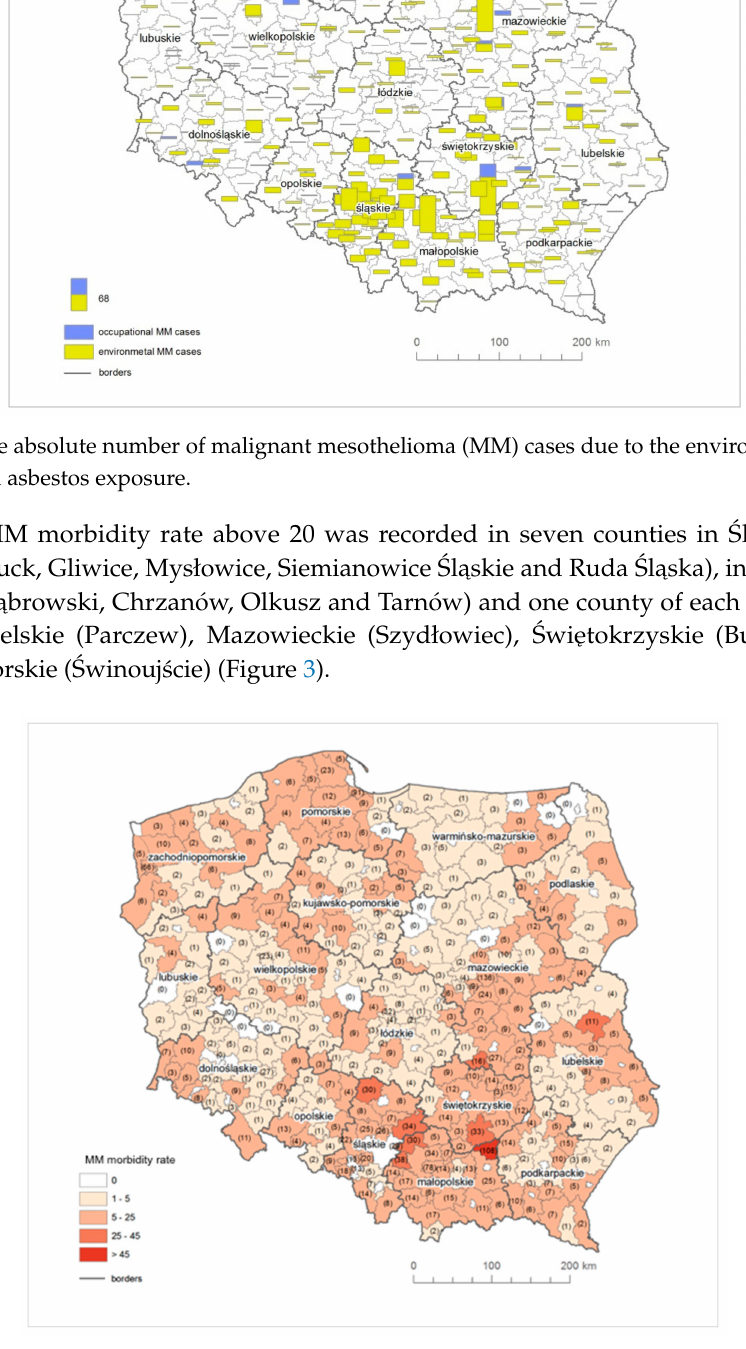
Figure 3. The raw MM morbidity rate in counties (in brackets: the absolute number of MM